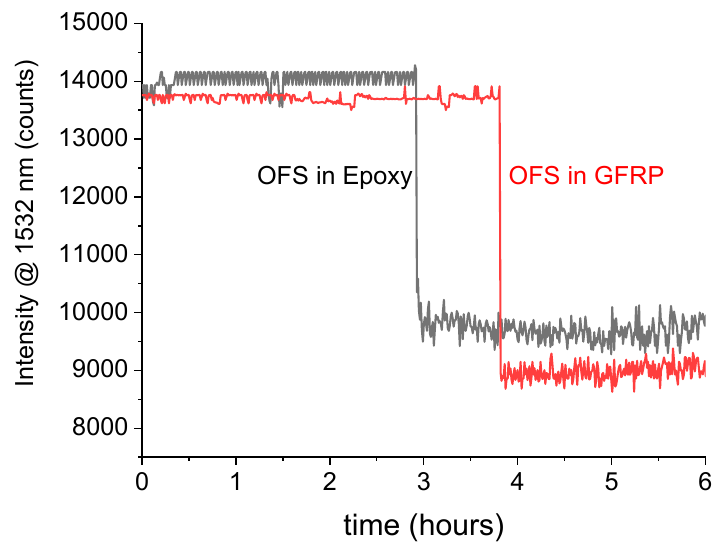
Figure 6. Signal intensity at a wavelength of 1532 nm from an OFS embedded in an epoxy and in a GFRP at depths of 0.9 ± 0.1 mm and 0.8 ± 0.1 mm, respectively. The samples were immersed in artificial sea water at 80 ◦ C and 50